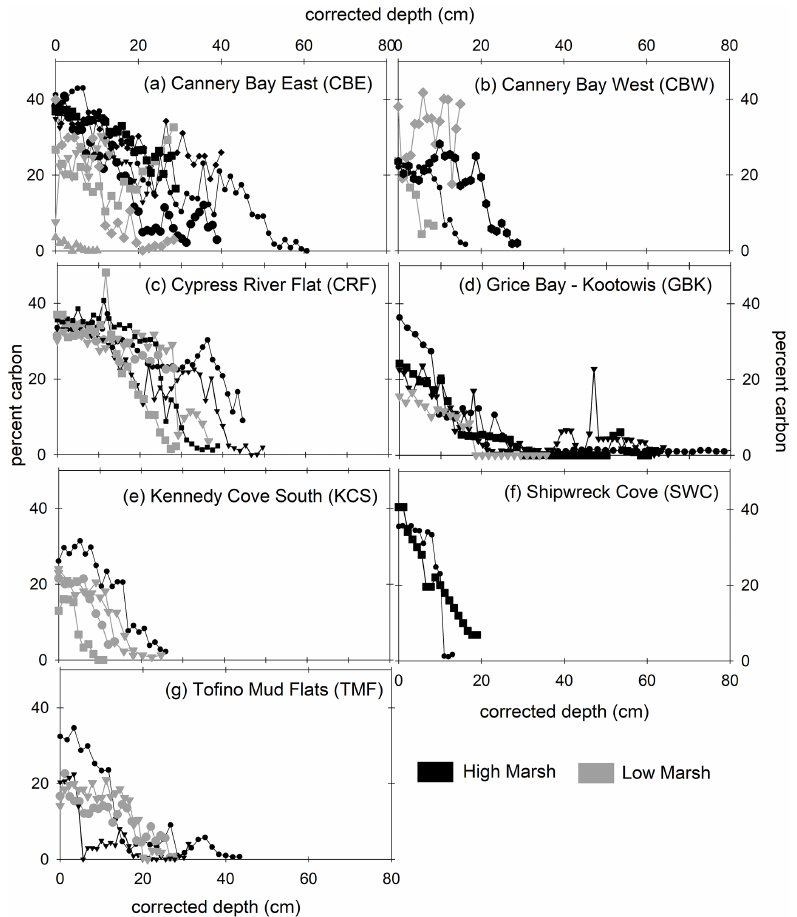
Figure 2. Percent carbon (vertical axis) versus depth (horizontal axis) for high marsh (black) and low marsh (grey) cores at all sites. Marsh name abbreviations are defined in Fig. 1. Depths have been corrected for core